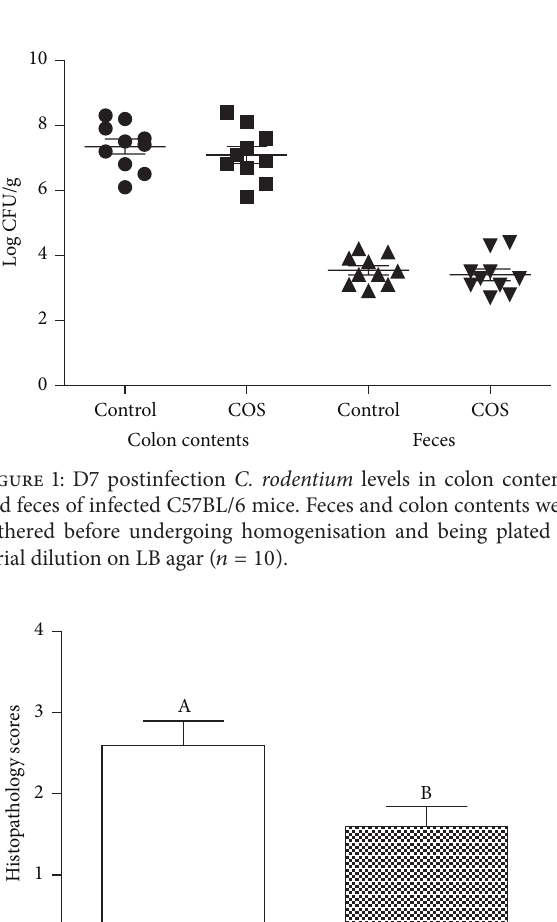
D 7 after infection